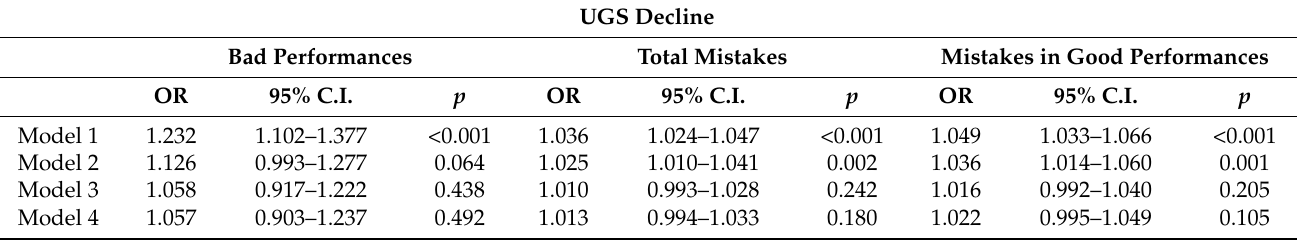
Table A6. Comparison of the OR and corresponding 95% C.I. of bad performances , total mistakes and mistakes in good performances for the prediction of UGS decline in the binary logistic regression models.